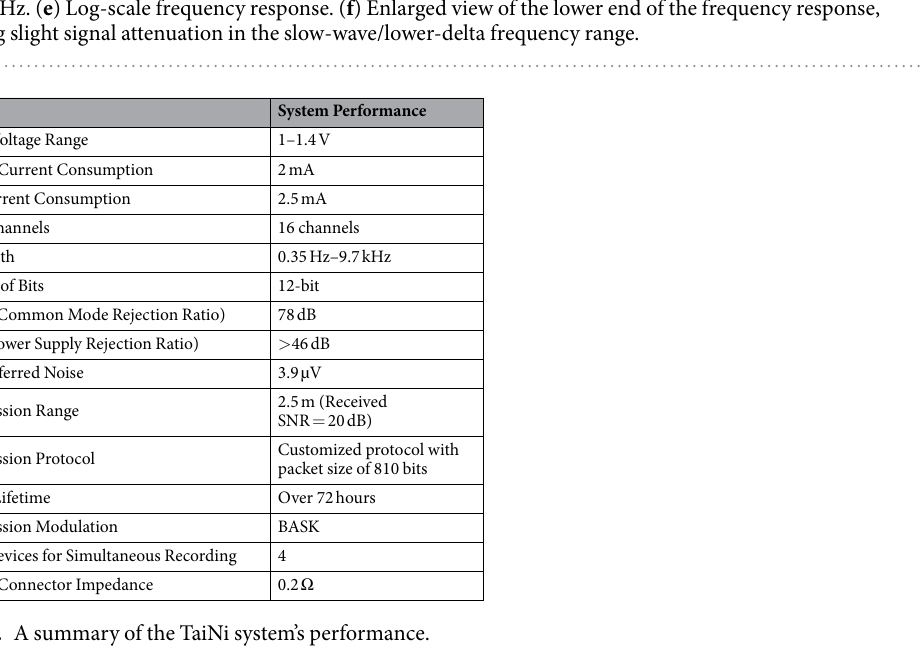
(Fig. 2e). The 0.5 Hz signal was only attenuated by 0.95 dB at 0.5 Hz, below the generally-held lower-bound for delta oscillations 17 , and by 7.5 dB at 0.1 Hz (Fig. 2f). In vivo tests. experimental settings. Each mouse was implanted with a 16-channel silicon probe (Cambridge NeuroTech, UK)